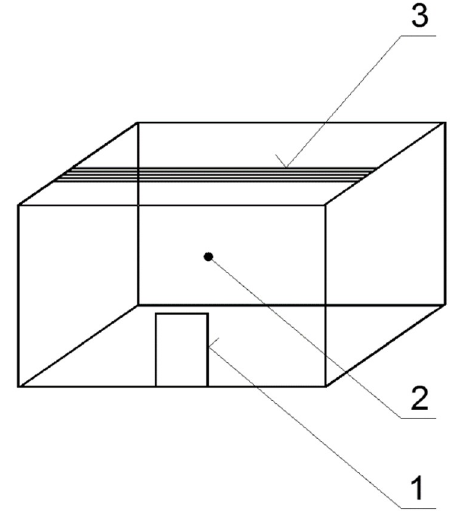
Figure 7. Scheme of production hall used in scenario: ( 1 ) Door, ( 2 ) Production hall, ( 3 ) Electrical cables. The smoke layer height (measured from smoke layer border and ceiling) was calculated according to Equation (6) [26].